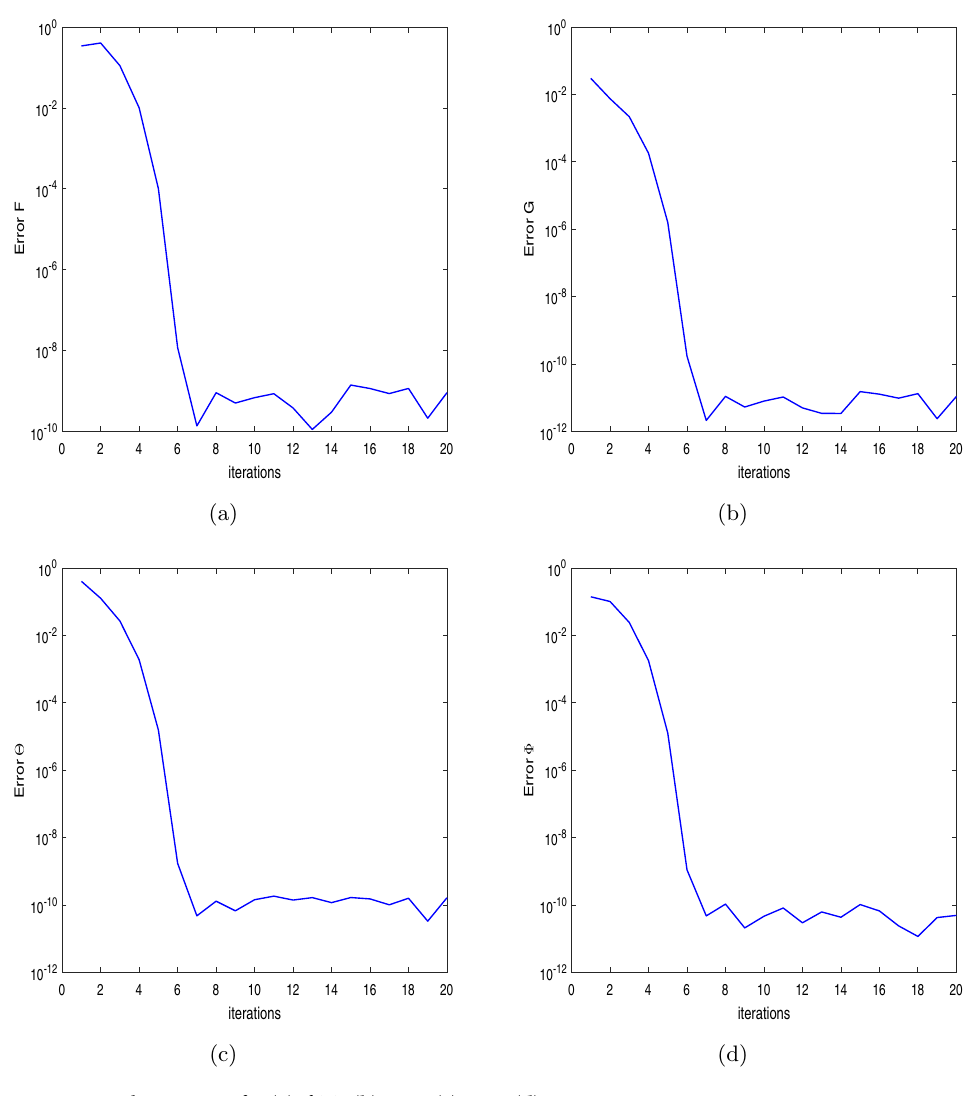
Figure 2. Solution error for ( a ) f (η) , ( b ) g (η) , ( c ) θ(η) , ( d ) φ(η)